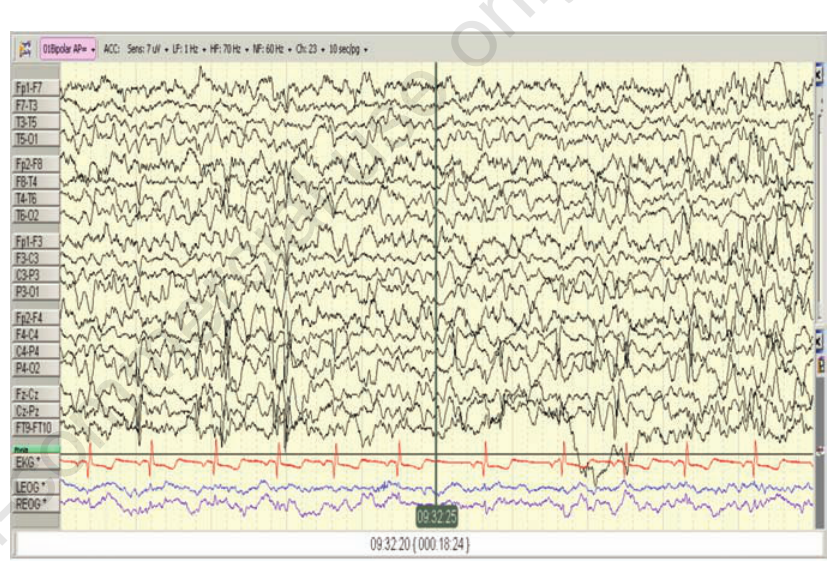
Figure 2. Example of frequent right sided discharges.